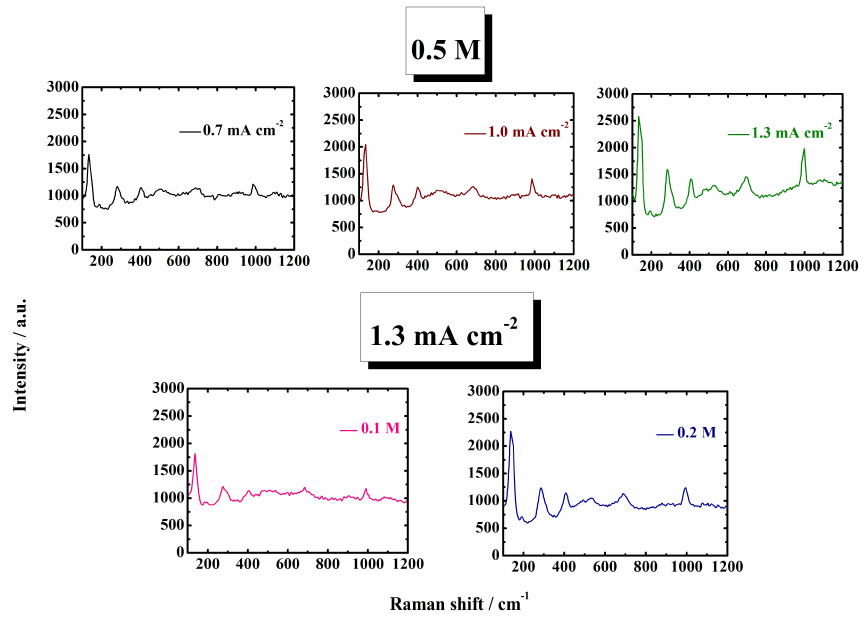
Figure 2. Raman spectra of the electrodeposited V 2 O 5 for current densities of 0.7, 1.0, 1.3 mA cm − 2 at a constant electrolyte concentration of 0.5 M and for electrolyte concentrations of 0.1 and 0.2 M at 1.3 mA cm − 2 .